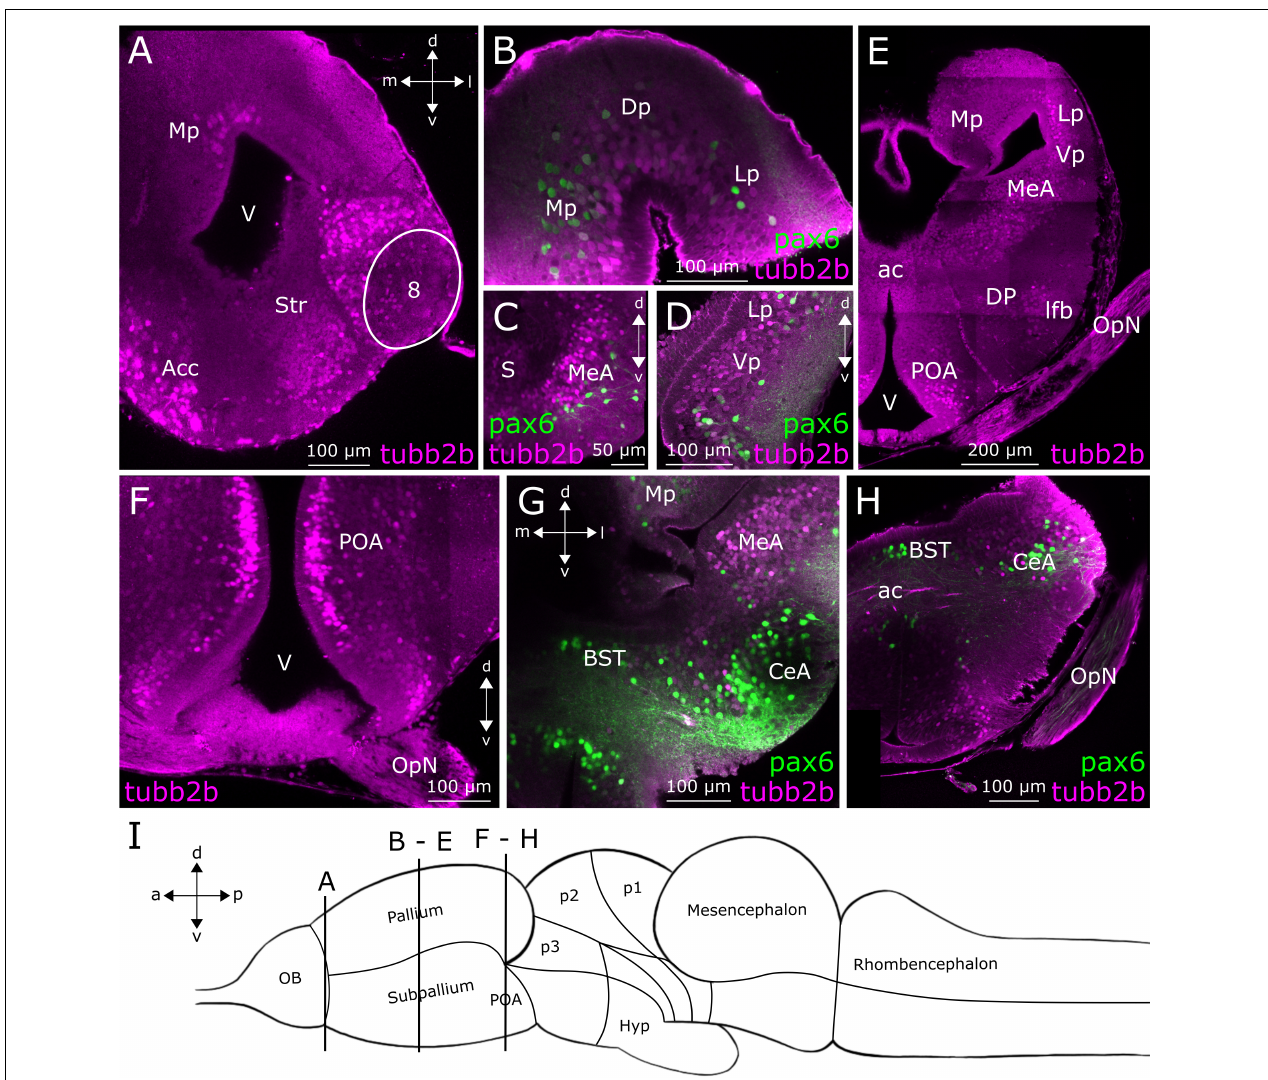
FIGURE 4 | tubb2b -dependent fluorescence in the telencephalon of larval Xenopus laevis . Coronal sections through the telencephalon of NBT-Katushka γ -cry-Venus (A,E,F) and NBT-Katushka pax6-GFP (B–D,G,H) transgenic tadpoles. (A) tubb2b -dependent fluorescence (magenta) in the anterior telencephalon. Stained cells could be detected in the nucleus accumbens (Acc), striatum (Str), accessory OB (projection field 8), and pallium. ( B–D) Close-ups of various zones of the anterior telencephalon showing tubb2b -dependent fluorescence in cells of the dorsal pallium (Dp), ventral pallium (Vp), medial pallium (Mp), lateral pallium (Lp), septum (S), and medial amygdala (MeA). (E) Sections through the posterior telencephalon showing tubb2b -dependent fluorescence in cells of the Mp, Lp, Vp, MeA, dorsal pallidum (DP), preoptic area (POA), and optic nerve (OpN). (F–H) Close-ups of various zones of the ventral posterior telencephalon. (F) tubb2b -dependent fluorescence in cells of the POA. (G,H) No overlap was detected between tubb2b - and pax6 -dependent fluorescence (green) in the POA, ac, and central amygdala (CeA). (I) Scheme of the larval brain showing the approximate positions (dashed rectangles) of the sections shown in (A–H) . Hyp, hypothalamus; OB, olfactory bulb; BST, bed nucleus of the stria terminalis; V, ventricle; d, dorsal; v, ventral; a, anterior; p, posterior; m, medial; l,